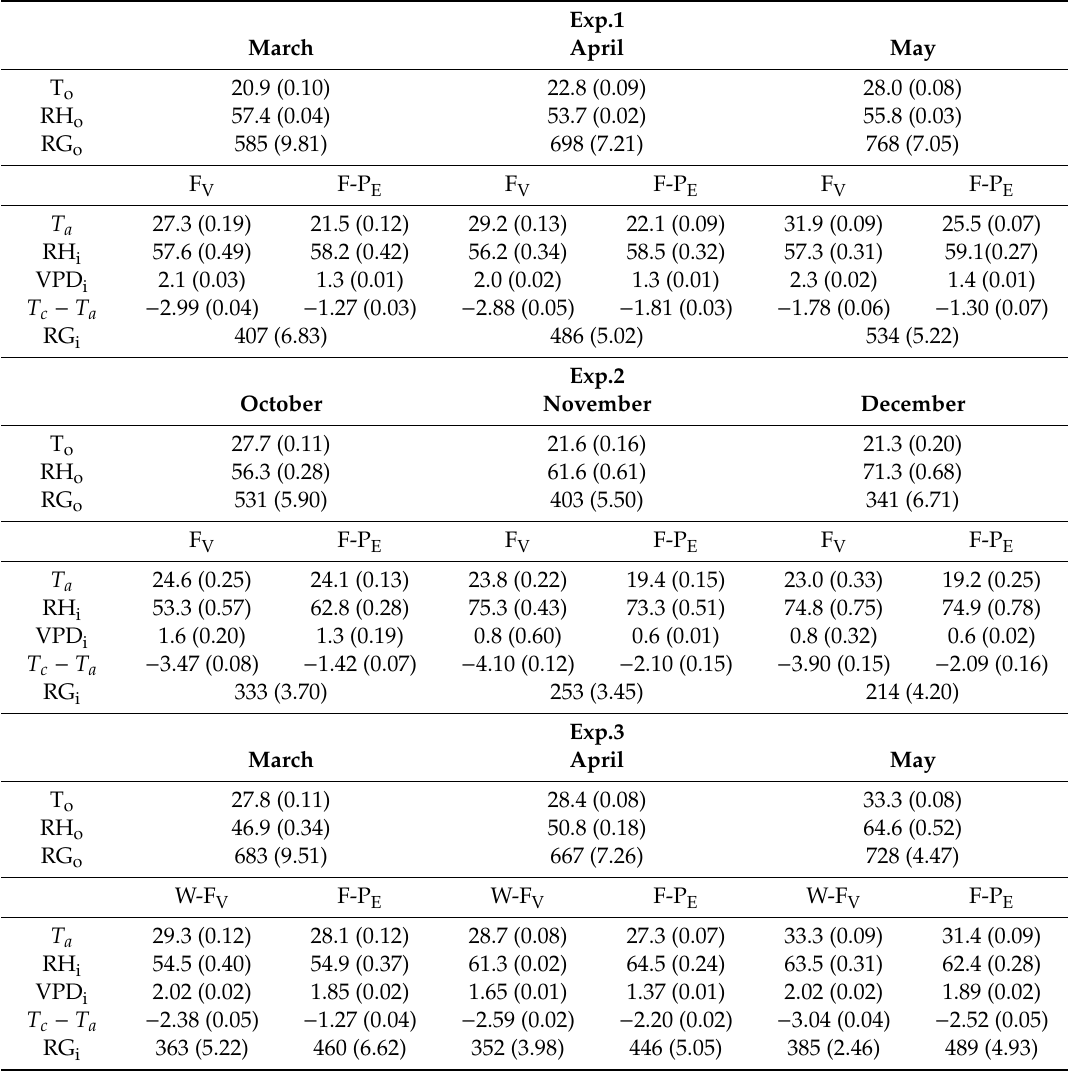
Table 1. Mean values ( ± standard error) of outside climatic data, leaf to air temperature di ff erences and internal greenhouse microclimates for daylight